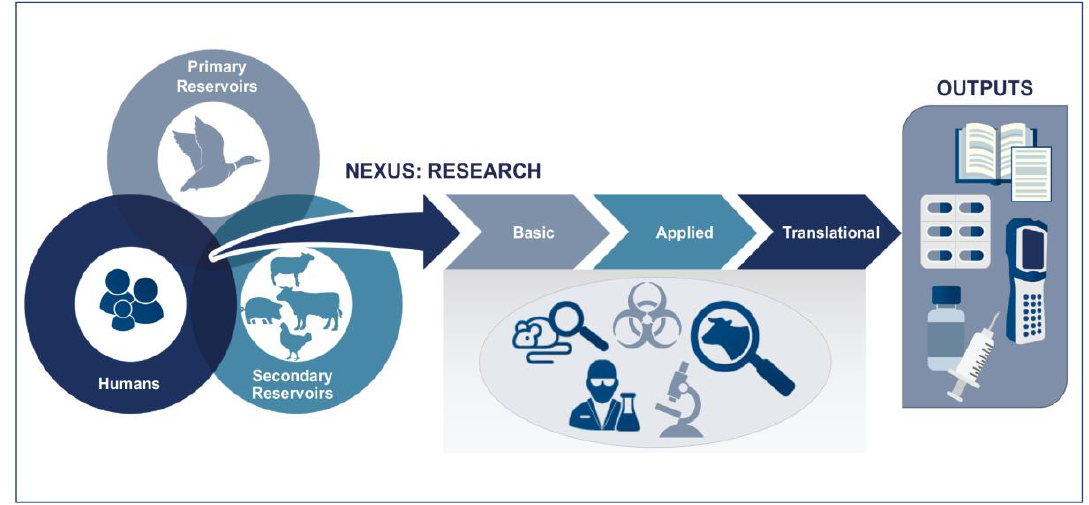
Figure 3. Diagram showing the intersection between animal health, human health and the ecological factors that must be considered when prioritizing research topics. The basic, applied, and translational scientific areas involve concerns of biosafety and biosecurity along with the operational considerations when choosing specific small or large animal models.